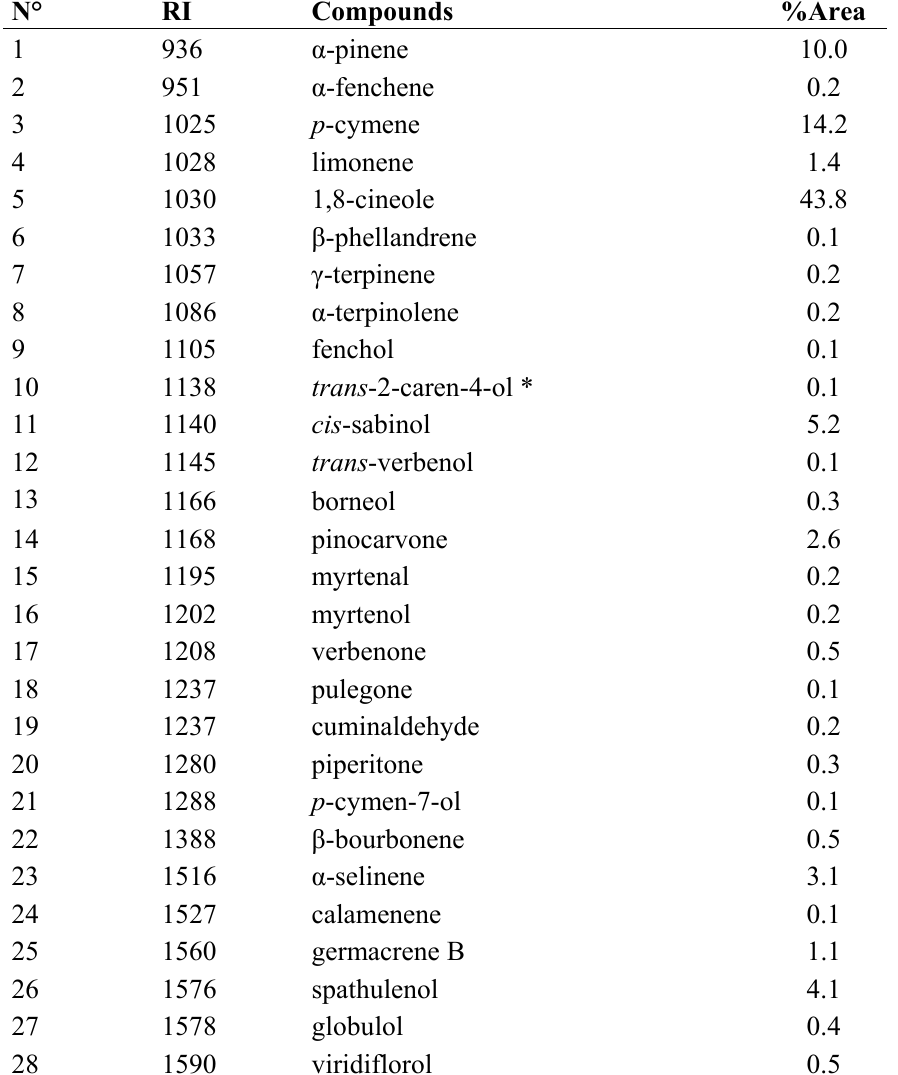
Table 1. Chemical composition of essential oil from E. gillii